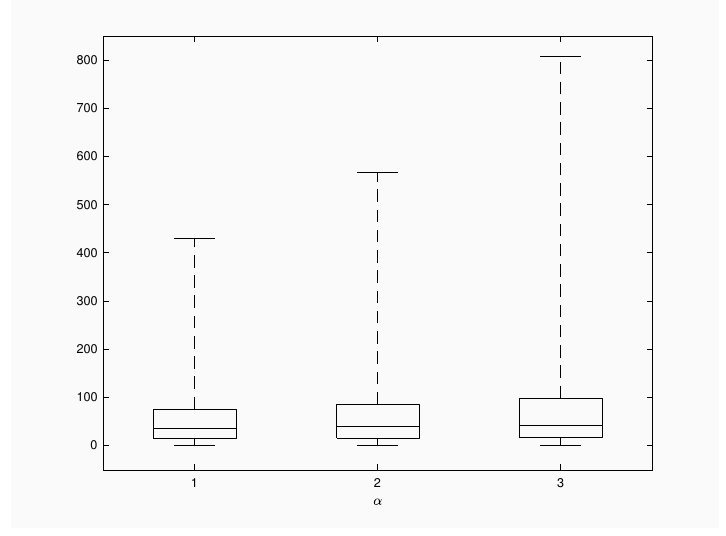
Figure 2. Box plot for T 1 .